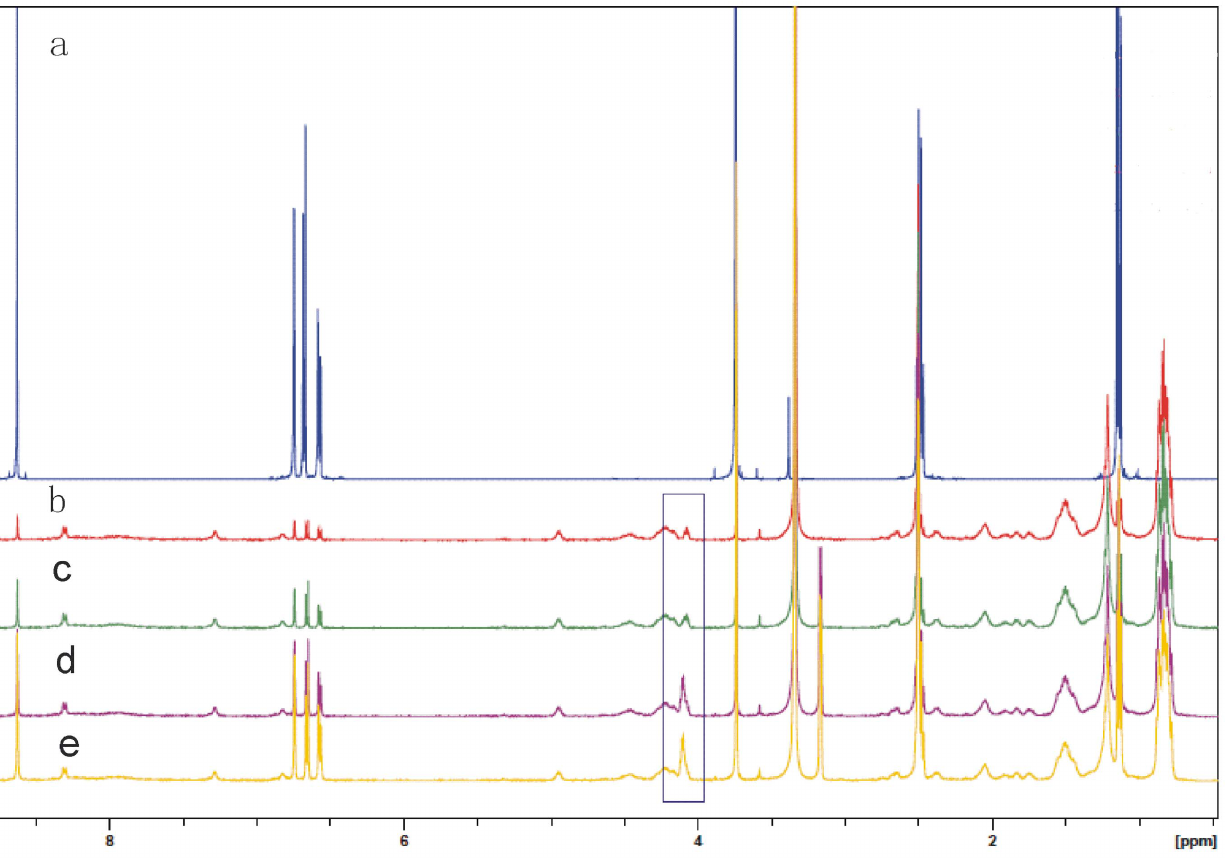
Figure 7. 1 H NMR spectra (400 MHz)ofnon-covalent complex lichenysins G:4-Ethyl Guaiacol inDMSO at 25 6 C; b) 4:1; c) 2:1; d) 1:1;e) 1:2.